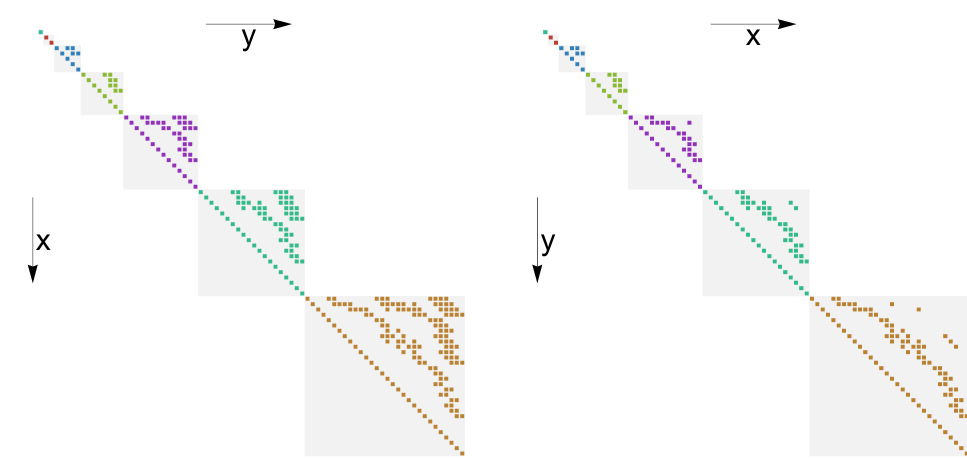
Figure 1 . Non-zero elements of the matrix h x | y i (Left) and its inverse (Right) up to SoV charge 6 . Blocks indicate fixed SoV